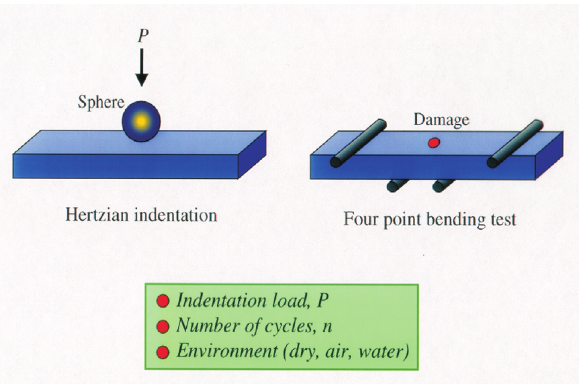
FIGURE 1 - Schematic of Hertzian contact fatigue testing of ceramic flexural test bars. Following contact testing ceramic is subject to 4-point bending at 0.5 mm per